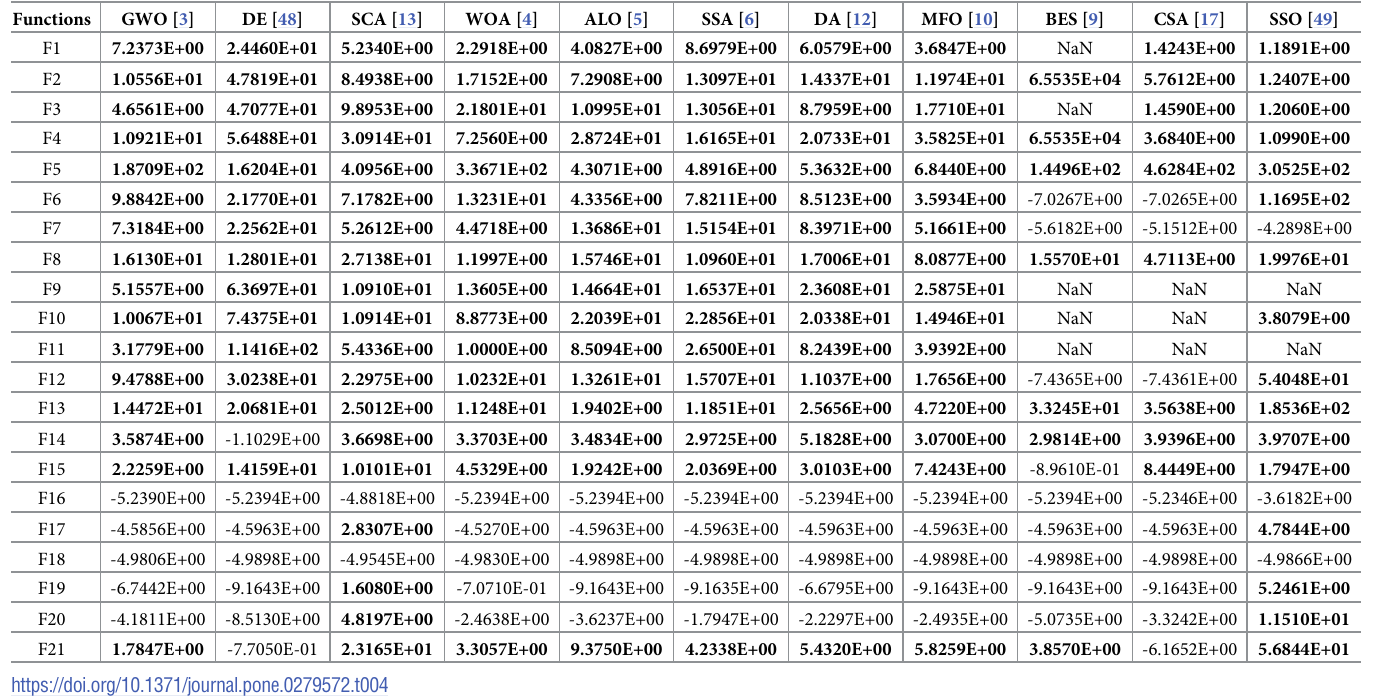
Table 4. Comparison of PSOLFWM with other meta-heuristic algorithms using t-Test. Functions